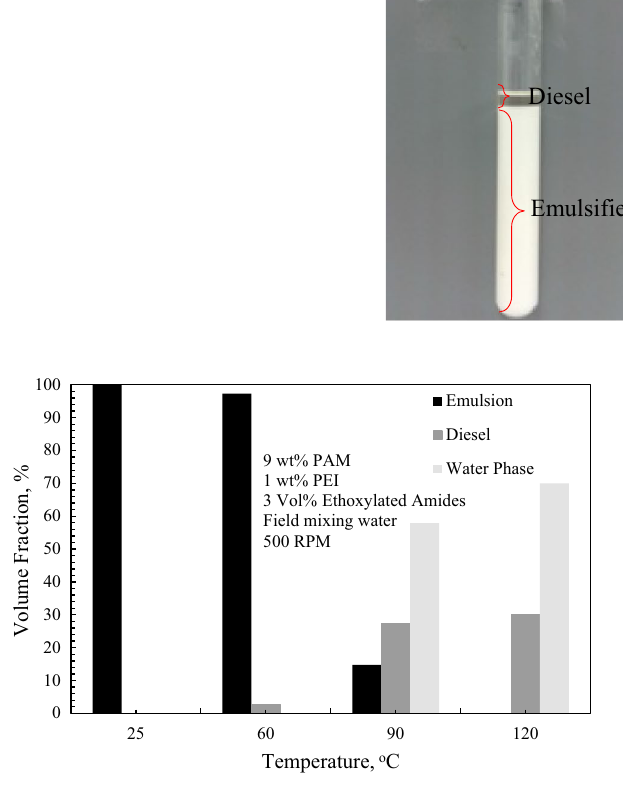
Fig. 10 Effect of WOR on the stability after 1 week at 25 °C: a 70/30 WOR, b 50/50 WOR and